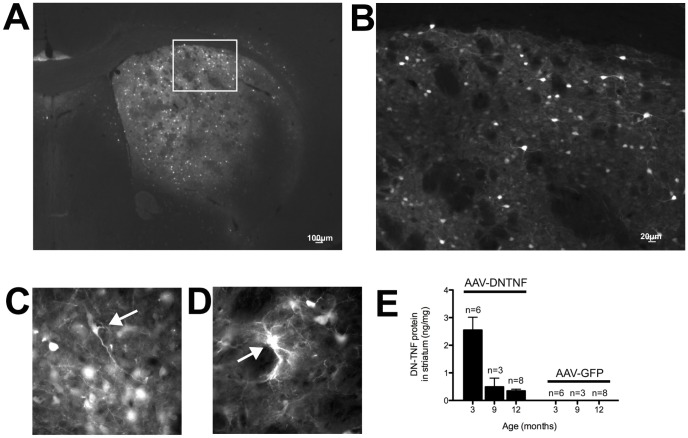
AAV-DN-TNF-GFP and AAV-GFP vector injections resulted in sustained transgene expression in the striatum.(A) GFP expression in a 12-month animal that received AAV-GFP vector injection. (B) Higher magnification view of boxed area. AAV vectors transduced (C) neurons and (D) glia (arrows). (E) DN-TNF ELISA using dissected striata from 3, 9 and 12-month animals indicates long-term expression of the DN-TNF transgene only in animals that received DN-TNF vectors.